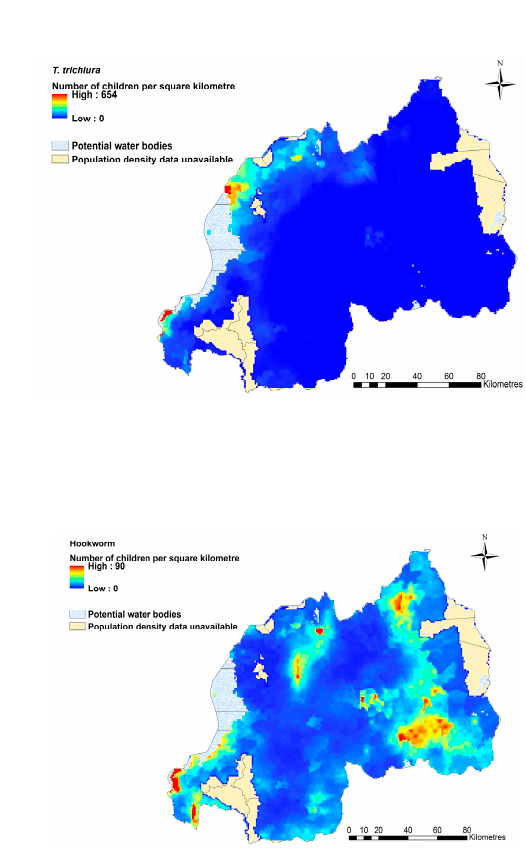
Figure 3. Distribution of number of children with predicted to harbour A. lumbricoides infection ( Panel A ), T. trichiura infection ( Panel B ), and hookworm ( Panel C ), (people per square kilometre) in Rwanda in 2018. Total population raster map is based on population density grid estimated using National Institute of Statistics Rwanda, Fourth Population and Housing Census 2012 data. This figure was produced in ArcMap 10.4 (ESRI, Redlands, CA) using a shapefile representing Rwanda’s current administrative units (obtained from the data warehouse DIVA GIS).